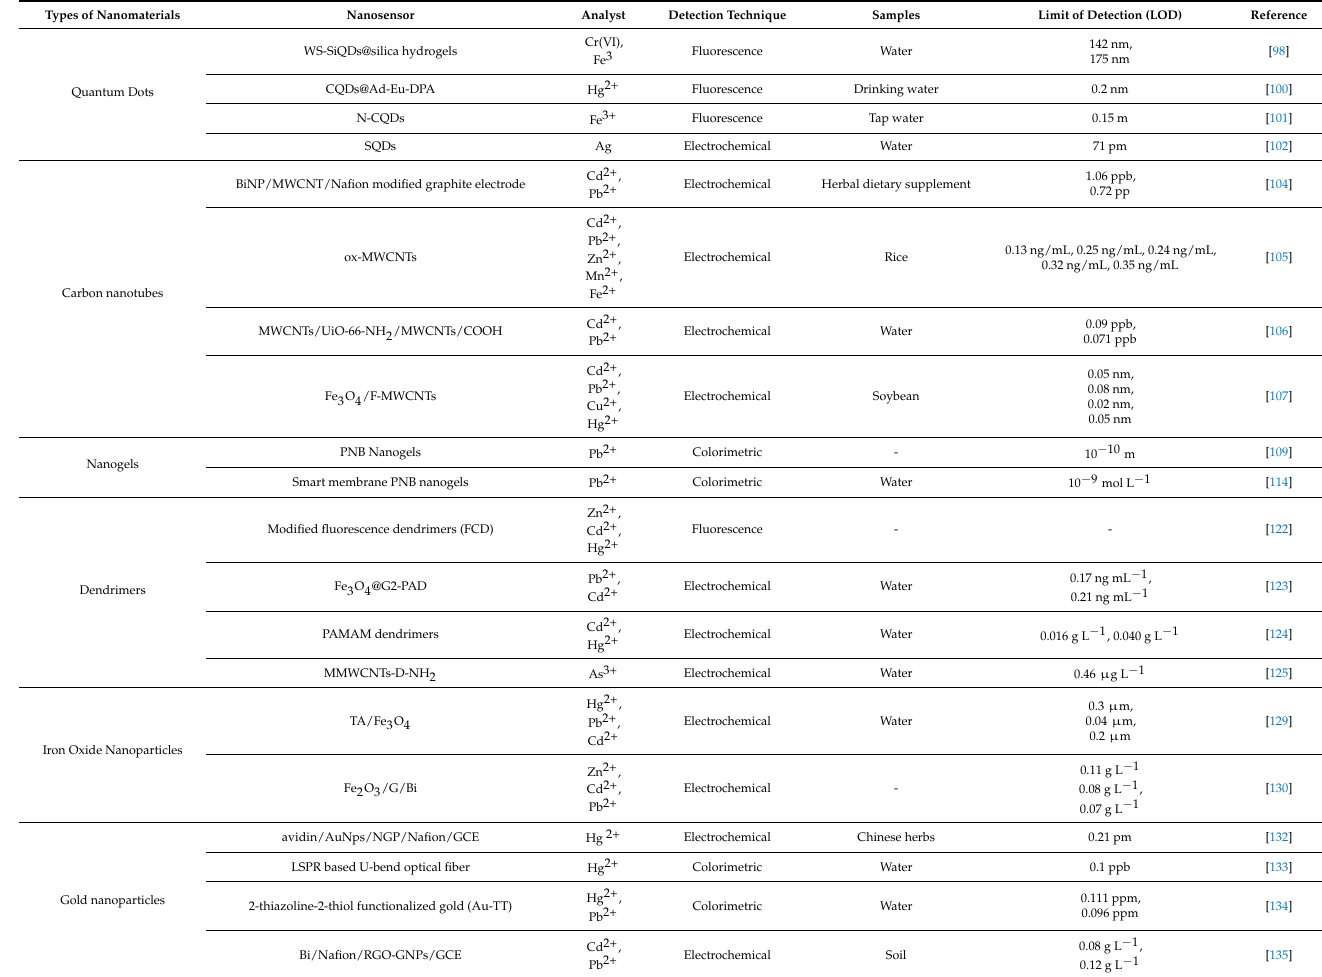
Table 3. Engineered nanomaterials for identification of heavy